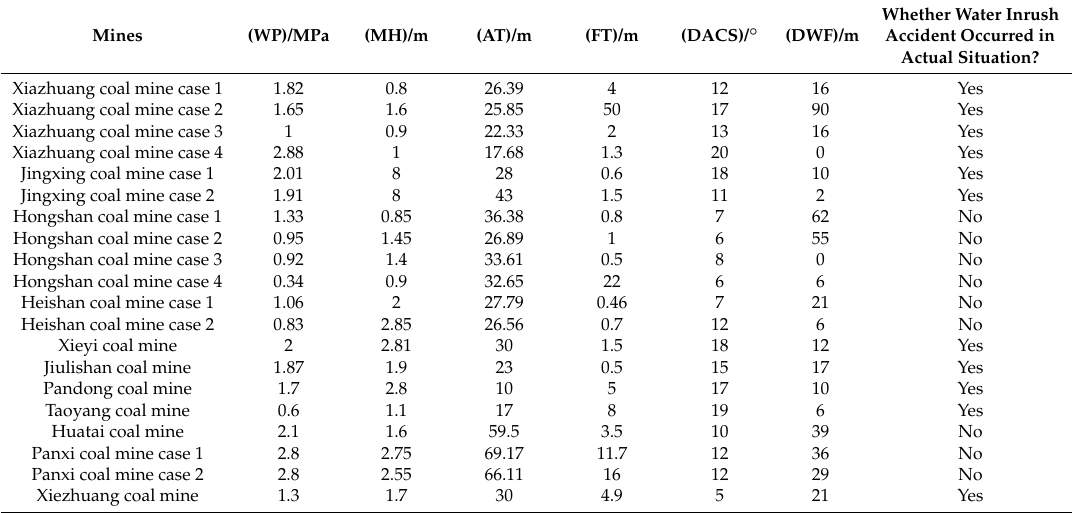
Table 1. Real water inrush cases used for ANFIS training (reported by Shi [43]). Mines (WP)/MPa (MH)/m (AT)/m (FT)/m (DACS)/ ◦ (DWF)/m